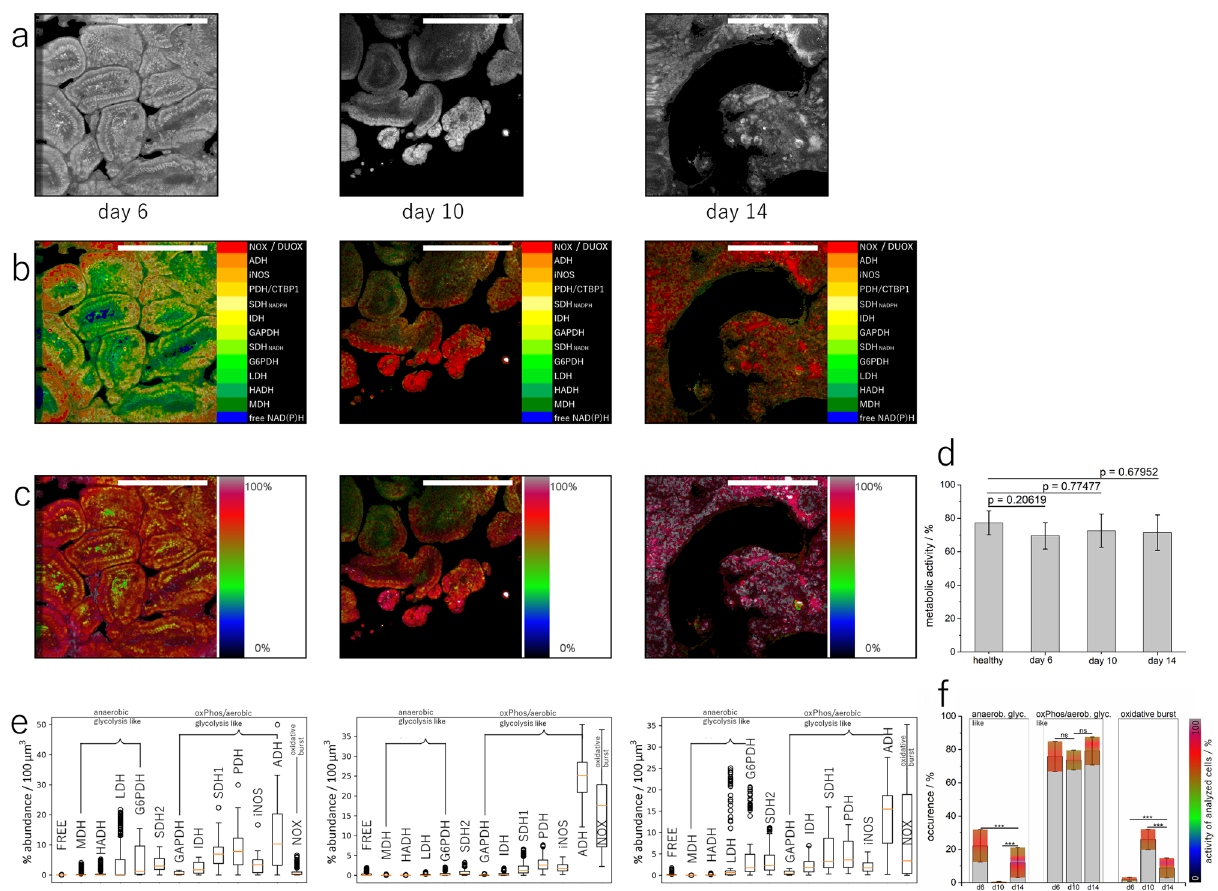
Figure 3. NAD(P)H fluorescence lifetime imaging of murine host duodenum from mice infected with H. polygyrus . (a) Representative NAD(P)H fluorescence sum images (500 × 500 × 100 µm 3 ) of host tissue (villi) at day 6, 10 and 14 after infection (masks generated by segmentation). Corresponding enzyme maps (b) and metabolic maps (c) of the NAD(P)H fluorescence sum images in (a) . Scale bar for all images = 250 µm. (d) General metabolic activity of infected mice as compared to healthy mice (n = 2 mice for day 6; n = 3 mice for day 10; n = 4 mice for day 14 and n = 7 healthy mice—Fig. 2). (e) Frequency graphs for the three time points during infection encompassing data from the same infected mice as in (d) . (f) Pixel frequencies of anaerobic glycolysis- like pathways, oxidative phosphorylation (oxPhos)/aerobic glycolysis-like pathways and oxidative burst, all given in percentage, for villi tissue (including epithelium and lamina propria, without further segmentation) encompassing all mice in (e) and Fig. 2d,e. The superimposed false color bar for each column indicates the corresponding general metabolic activity per pixel, in percent. Statistical analysis in (d,f) was performed using ANOVA test with Bonferroni multi-column post-test (ns p > 0.05, *p < 0.05, **p < 0.01, ***p < 0.001). Figure generated with Paint.NET, https:// www. getpa int. net/ downl oad.